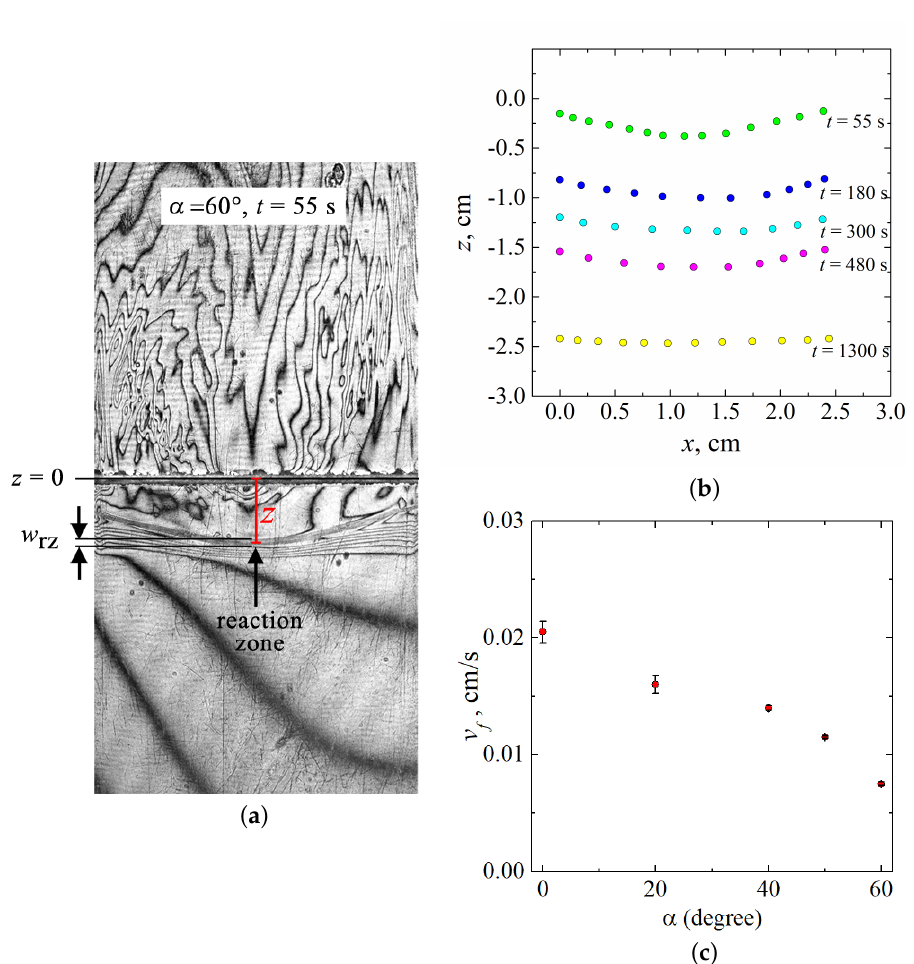
Figure 5. ( a ) Scheme of the measurement of the front position coordinate. ( b ) Temporal evolution of the shape of the reaction front in ( x , z ) -plane shown for α = 60 ◦ . The line z = 0 cm corresponds to the initial contact surface between reacting solutions. ( c ) Velocity magnitude of the reaction front as a function of the inclination angle α